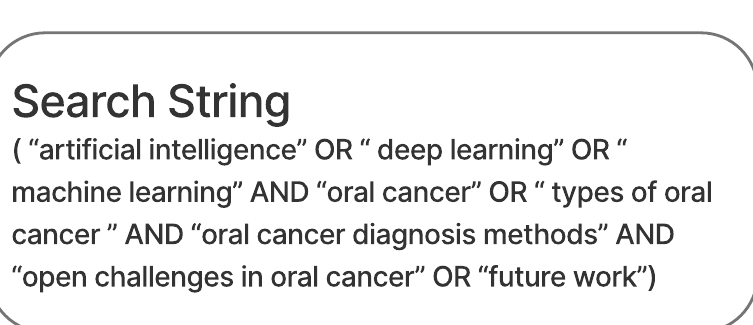
Figure 1. Inquiries made using key terms in databases.